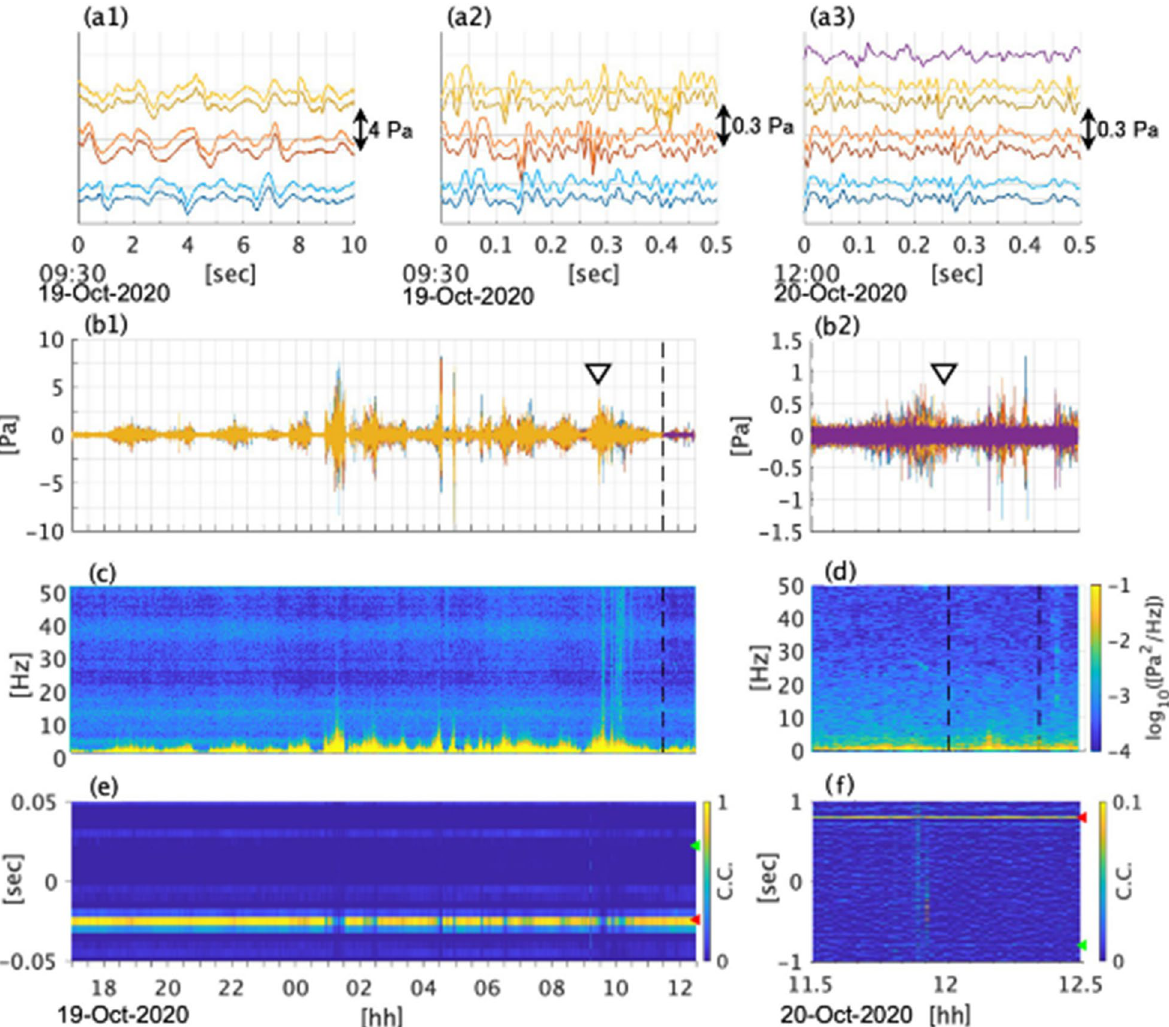
Fig. 2 Waveforms, spectrograms, and correlation coefficients. a Examples of the observed waveforms at 0.3–80 Hz ( a1 , a3 ) and 5–80 Hz ( a2 ). The line colors indicate the microphones (blue, A1; red, A2; yellow, A3; purple, SI). The lower darker blue, red, and yellow lines in ( a1 – a3 ) show the waveforms recorded by the collocated MEMS microphones. b – f The waveforms at 0.3–80 Hz ( b1 , b2 ), the spectrograms ( c , d ), and the cross-correlation coefficients (CCs) ( e , f ) acquired during the array observation on the left ( b1 , c , e ) and with the SI observation on the right ( b2 , d , f ). The black dashed line in b1 indicates the start time for b2 . The black triangles in b1 and b2 mark the origin times of a1 , a2 and a3 , respectively. The displayed spectrograms are of A1 ( c ) and SI ( d ), the array CC between A1 and A3 ( f ), and the SI-array CC between SI and A1 ( e ) using the waveforms at 5–80 Hz. The arrowheads on the right axis in e and f indicate the lag times between the microphones assuming the ISC source (red) and IWC source (green). The waveforms, spectrograms, and CCs for the other microphones are presented in Additional file 1: